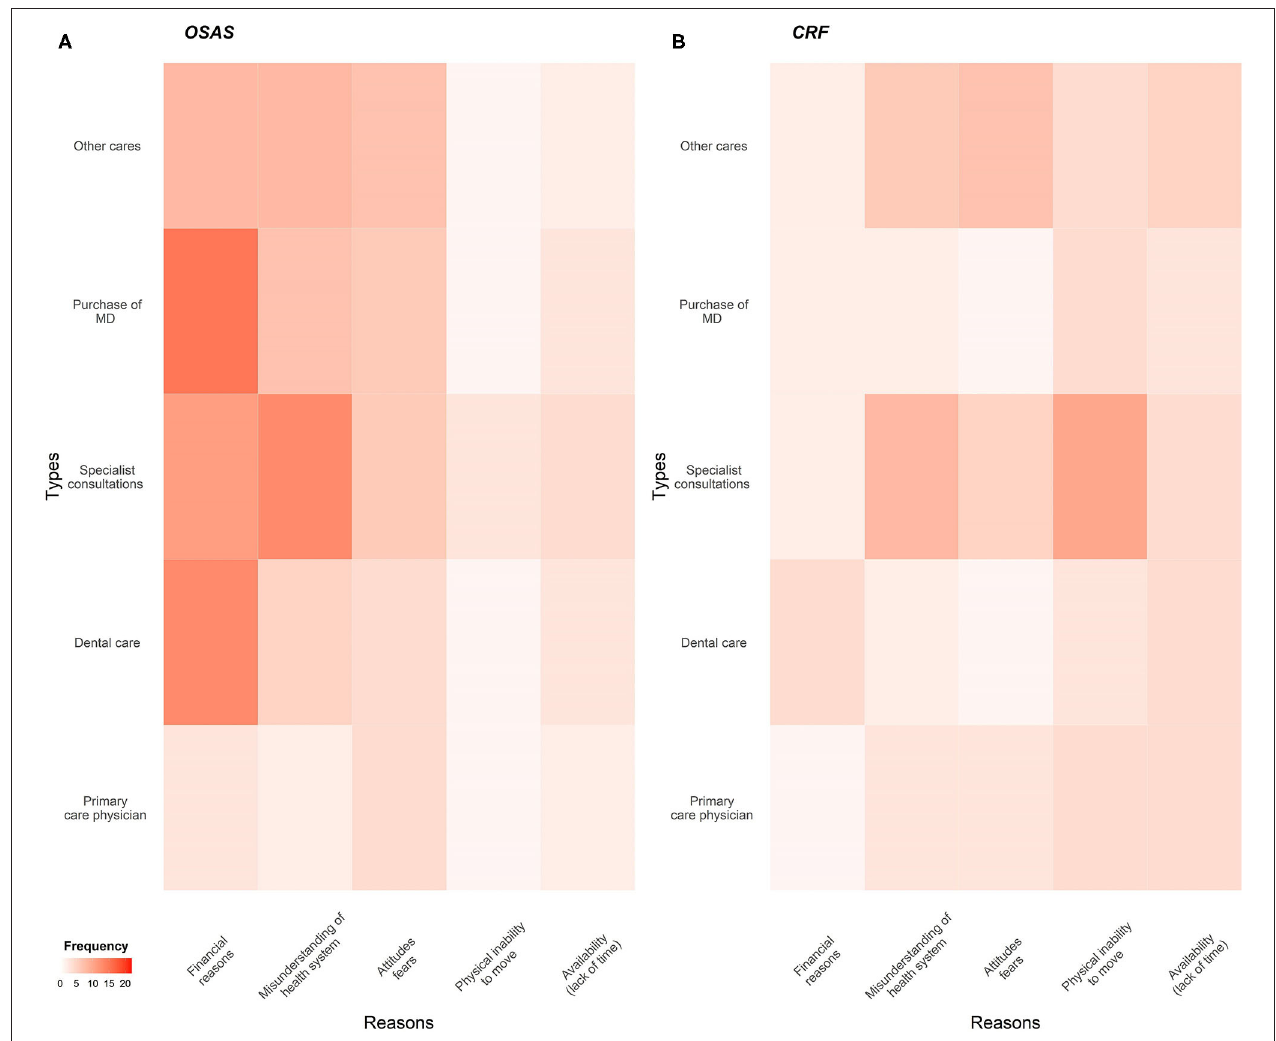
FIGURE 2 | Heatmap displaying the types and reasons of healthcare non-take up. (A) OSAS patients; (B) CRF patients. MD, medical